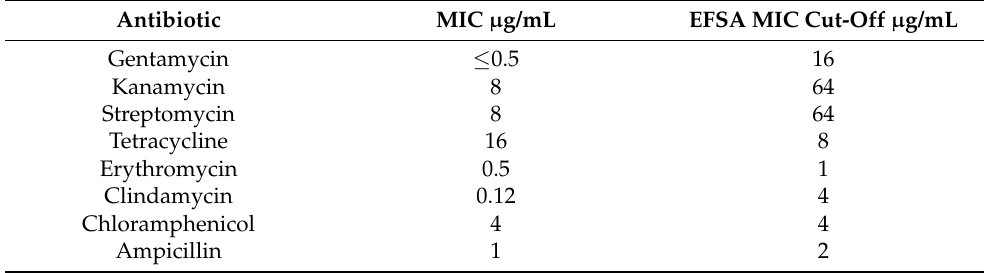
Table 3. Minimum Inhibitory Concentrations (MIC) of antibiotic required by EFSA for CNCM I-4884.